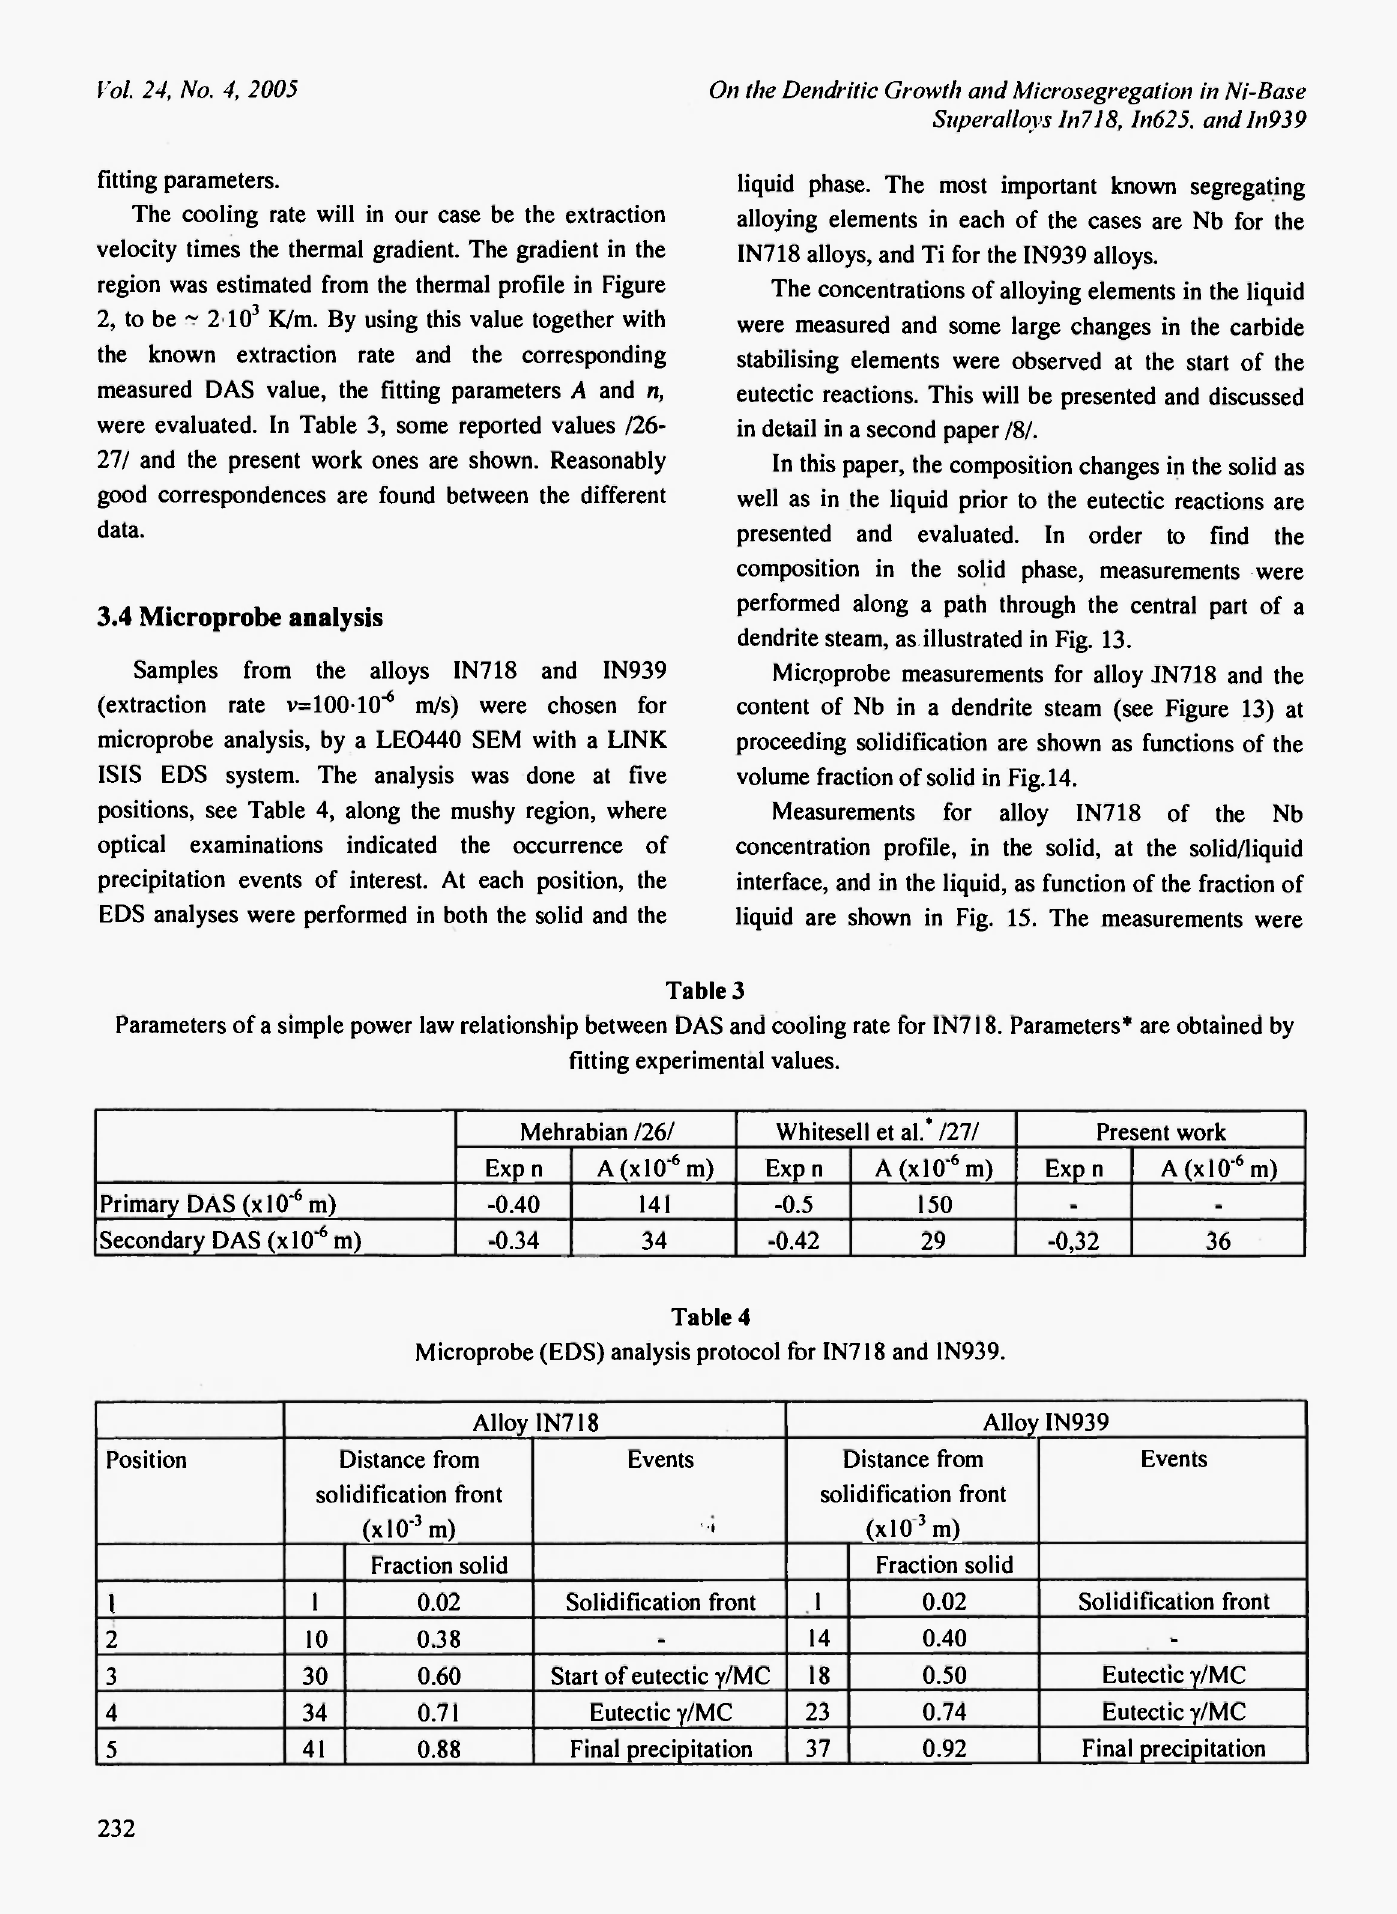
Microprobe (EDS) analysis protocol for IN718 and